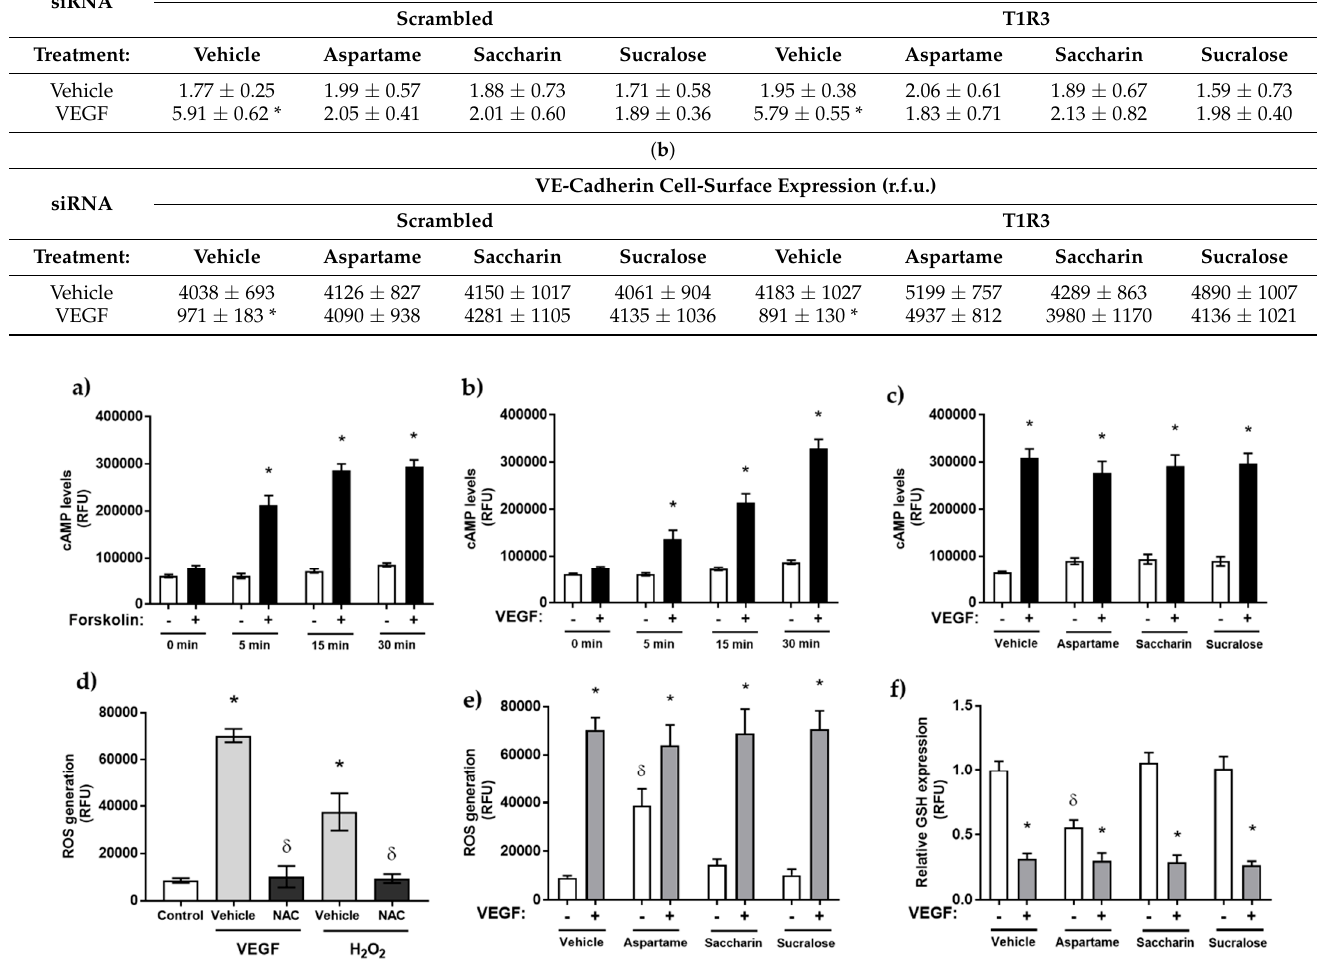
Figure 3. Artificial sweetener regulation of the glomerular endothelium is independent of cAMP and intracellular ROS generation. Panel ( a – c ): generation of intracellular cAMP upon exposure of GMVEC to aspartame (10 µ M), saccharin (0.1 µ M), and sucralose (0.1 µ M) for 24 h in the presence and absence of VEGF (panel b ) using the cAMP-Screen Direct chemiluminescent ELISA assay. Forskolin (FSK), 10 µ M, was used to validate the assay (panel a ). Panel ( d – f ): GMVEC were treated with VEGF or H 2 O 2 (10 µ M) or vehicle (H 2 O) in the presence or absence of NAC (10 µ M), followed by incubation with DCFDA (10 µ M) and fluorescence analysis (panel d ). These experiments were repeated following pre-exposure to aspartame (10 µ M), saccharin (0.1 µ M), and sucralose (0.1 µ M) for 2 h in the presence and absence of VEGF (panel e ). ROS production was assessed by measuring the florescence level of DCF following staining with 10 µ M DCFDA. For cellular glutathione (GSH) measurements (panel f ), GMVEC were pre-exposed to aspartame (10 µ M), saccharin (0.1 µ M), and sucralose (0.1 µ M) in the presence and absence of VEGF. Data are expressed as mean with S.E.M and n = 6. * p <0.05 vs. vehicle for sweetener; δ p < 0.05 vs. vehicle for VEGF or H 2 O 2 .